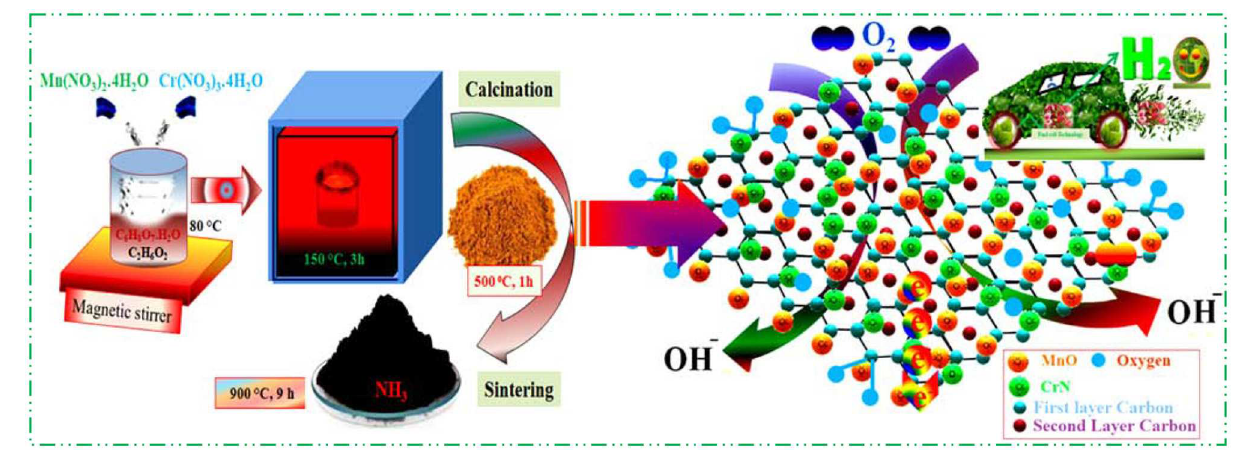
FIGURE 1 | Scheme for Cr/rGO with MnO electrocatalyst synthesis and its proposed ORR application. rGO, reduced graphene oxide; ORR, oxygen reduction reaction.